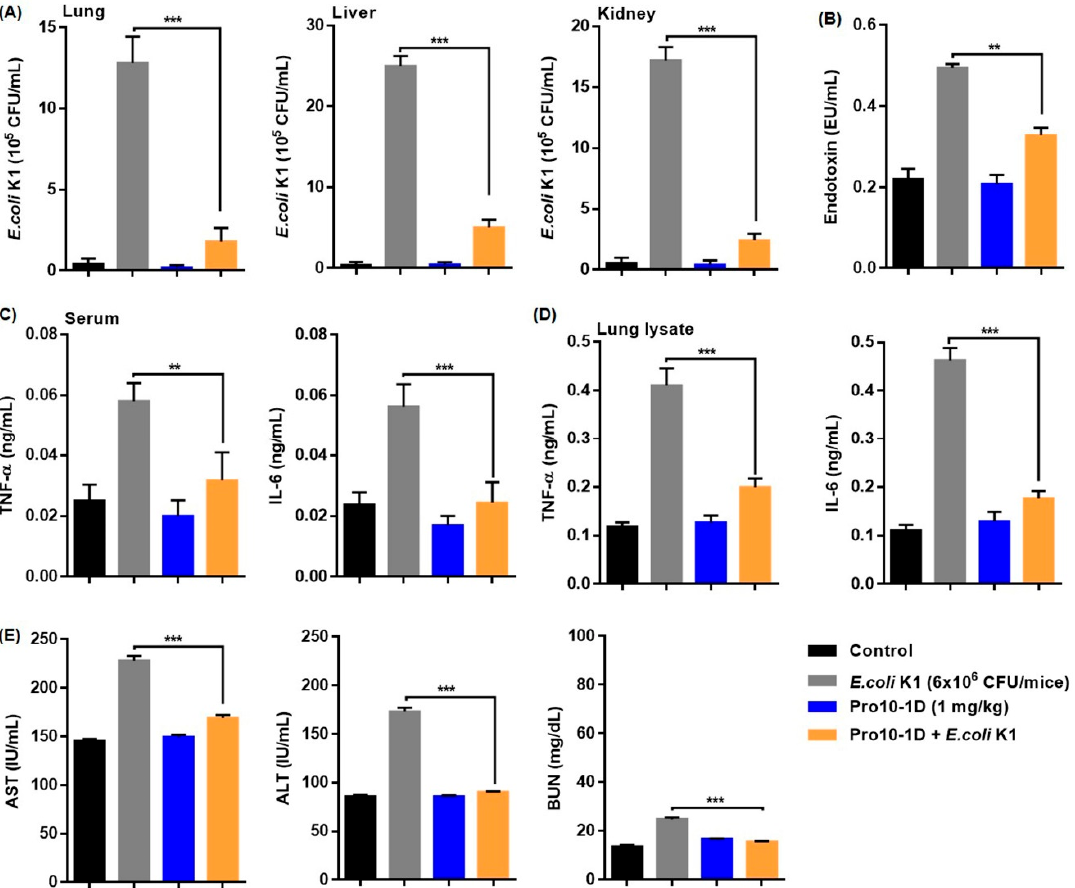
Figure 12. Pro10-1D treatment alleviates septic shock in E. coli K1-infected mice: ( A ) Inhibition of bacterial growth by Pro10-1D in the lung, liver, and kidney lysates of the septic mice. Mice were pretreated with 1 mg/kg of Pro10-1D (1 h) and E. coli K1 (6 × 10 6 Colony-Forming Unit (CFU)/mice, 16 h). ( B ) Pro10-1D reduces circulating endotoxin (LPS) levels in serum of septic mice. Effect of Pro10-1D on TNF- α and IL-6 levels in the ( C ) serum, and ( D ) lung lysates of septic mice. ( E ) Pro10-1D normalizes the serum levels of ( E ) aspartate aminotransferase (AST), alanine aminotransferase (ALT), and blood urea nitrogen (BUN) in septic mice infected with E. coli K1. The graphs indicate the mean ± SEM (5 mice/group). ** p < 0.01; *** p < 0.001; ns, nonsignificant (by one-way ANOVA , Tukey’s post hoc test ).